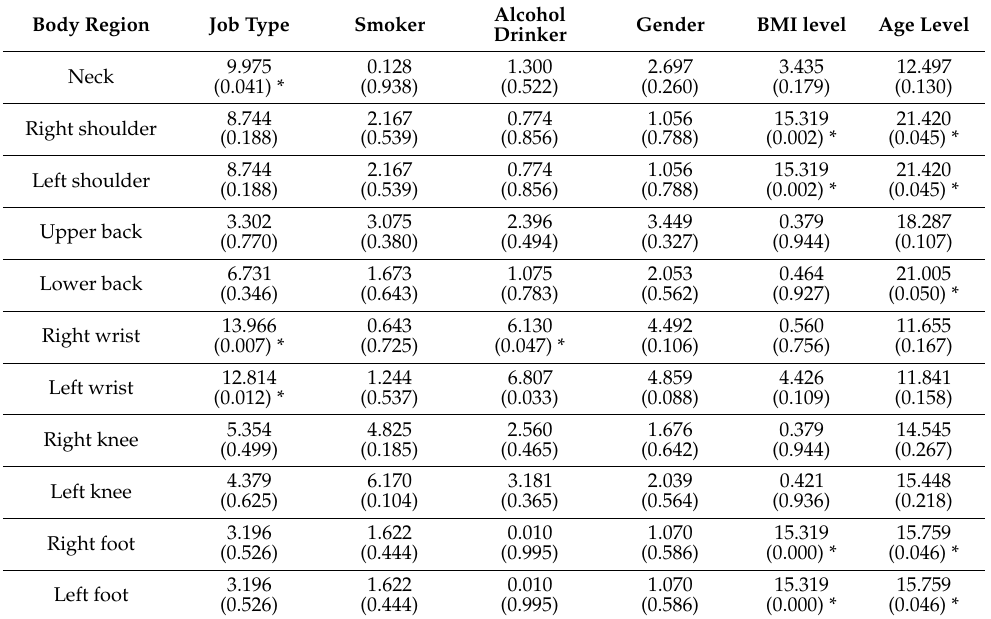
Table 8. Pearson chi-square test musculoskeletal symptoms by